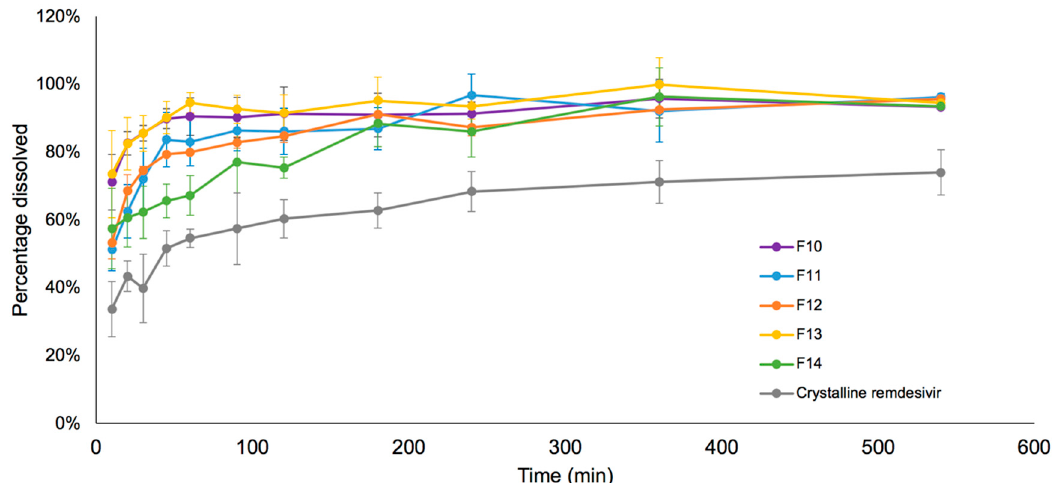
Figure 8. Dissolution profiles of TFF remdesivir dry powder compositions in simulated lung fluid.